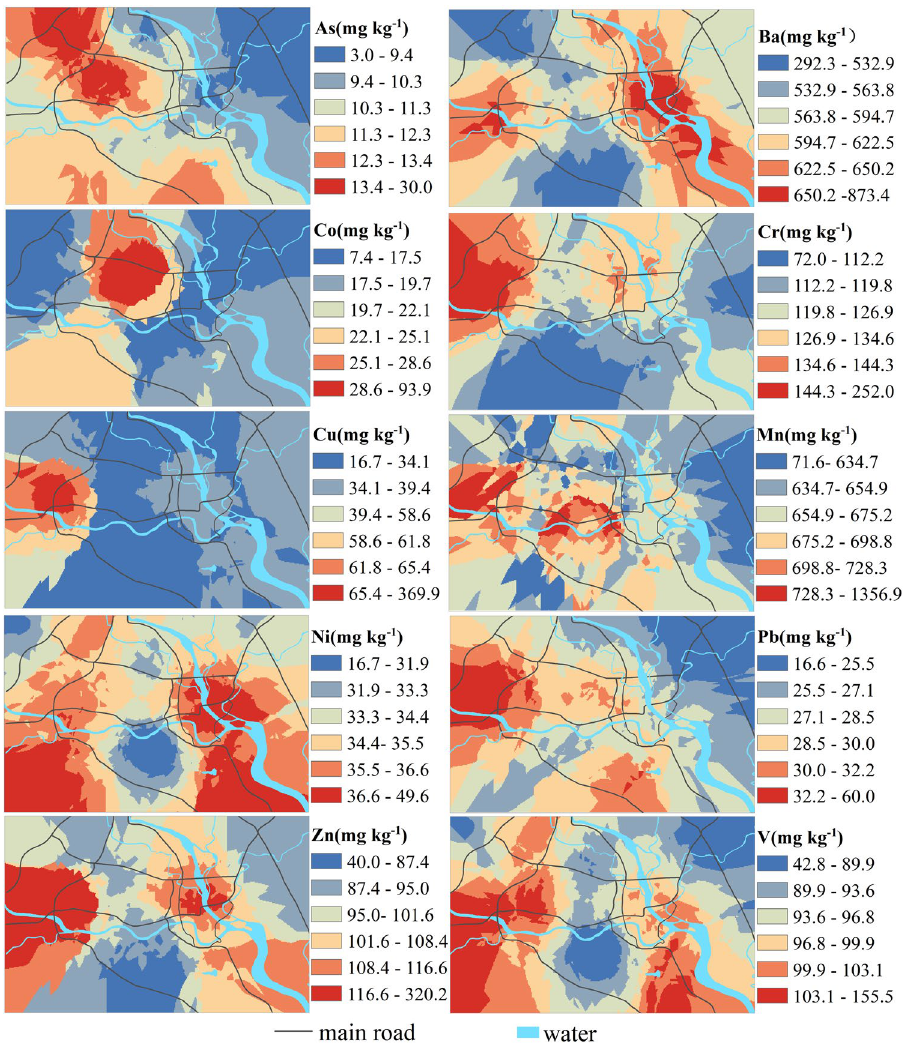
Figure 2. Spatial distribution of HM contents in the topsoil of Mianyang [the figure was generated by Huaming Du using the ArcGIS 10.3 (https:// devel opers. arcgis.